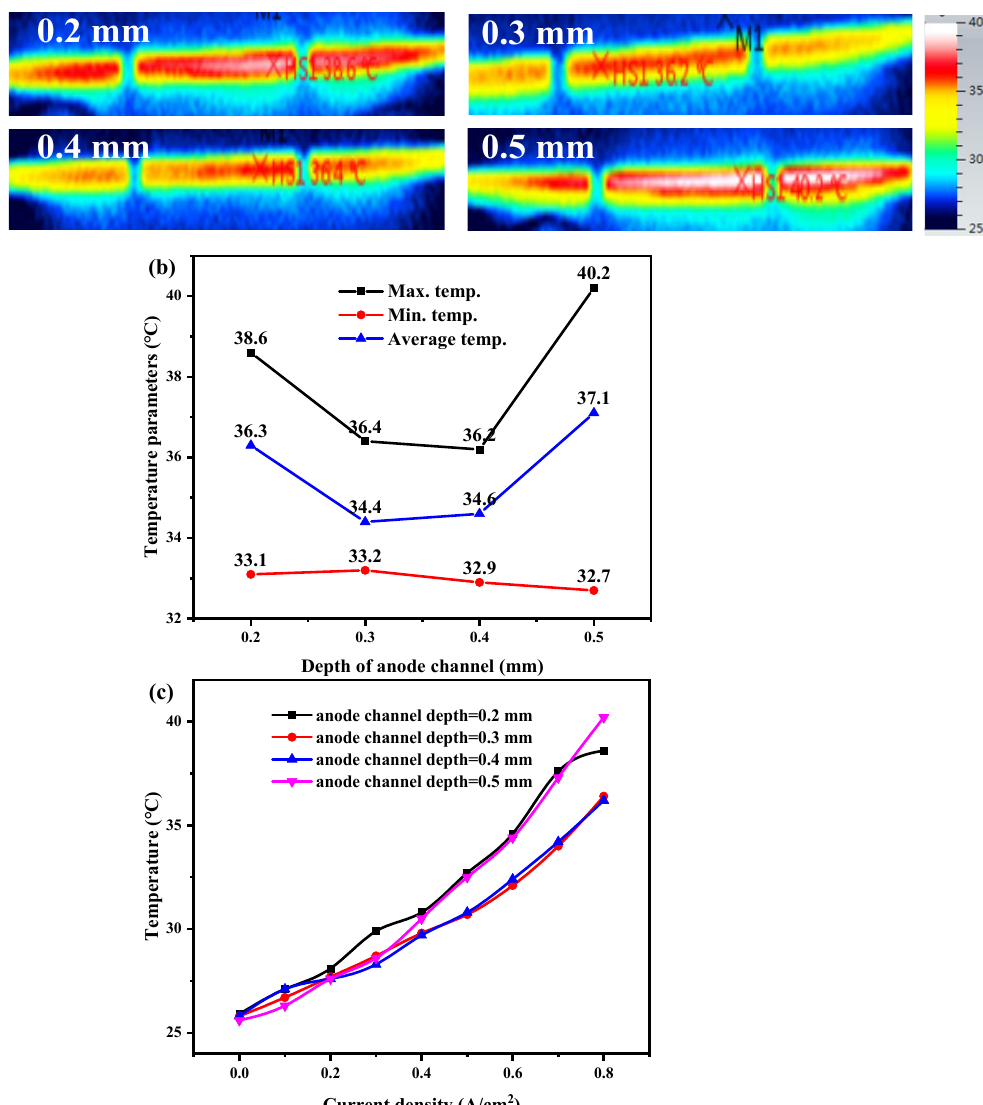
Figure 6. ( a ) Temperature distribution at 0.8 A/cm 2 , ( b ) maximum, minimum, and average temperatures, and ( c ) variation of hot spot temperature with current densities of the open-cathode PEMFC with different anode serpentine channel depths.